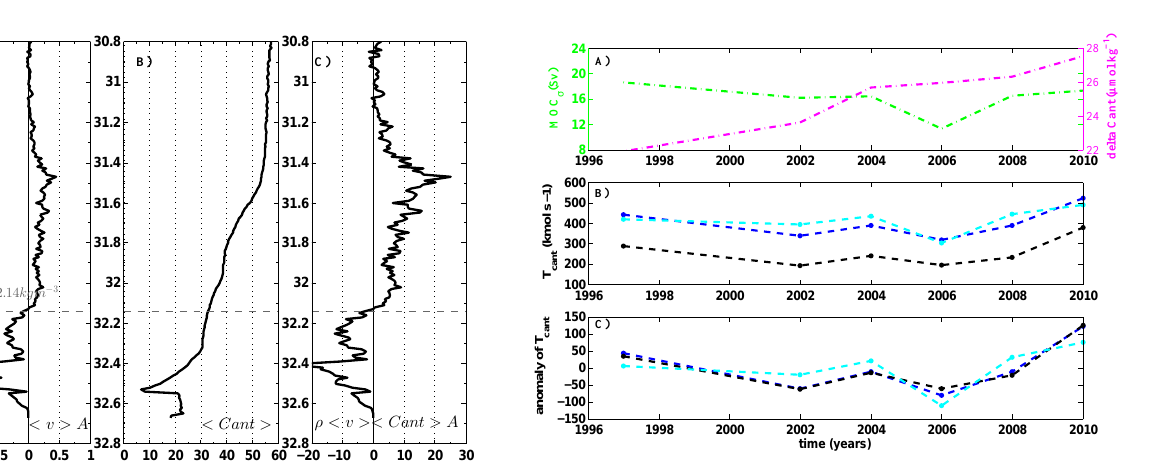
Fig. 6. (A) Time evolution of the intensity of the MOC σ (in green) and the difference in Cant between the upper and lower limbs of the MOC σ (in pink). (B) Time evolution of T cant (black line), T diap cant ◦ (blue line) and T cant computed by the estimator ( T cant , cyan line). (C) Time evolution of anomalies of T cant (black line), T diap cant (blue ◦ line), T cant (cyan line), the anomalies in relation to the mean value computed over